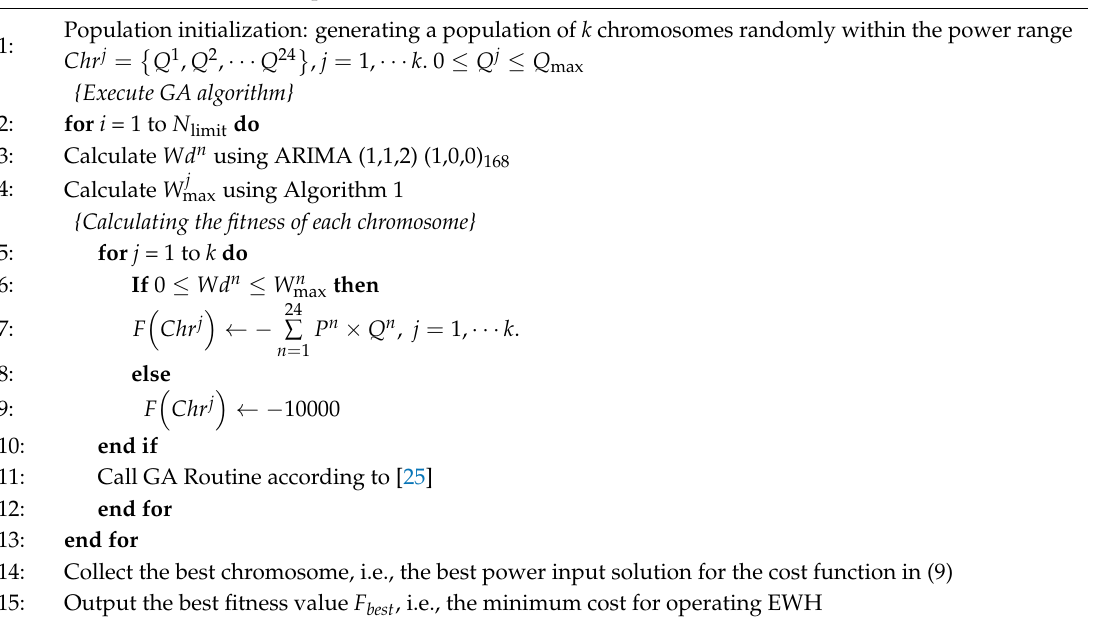
Algorithm 2 : GA-based EWH